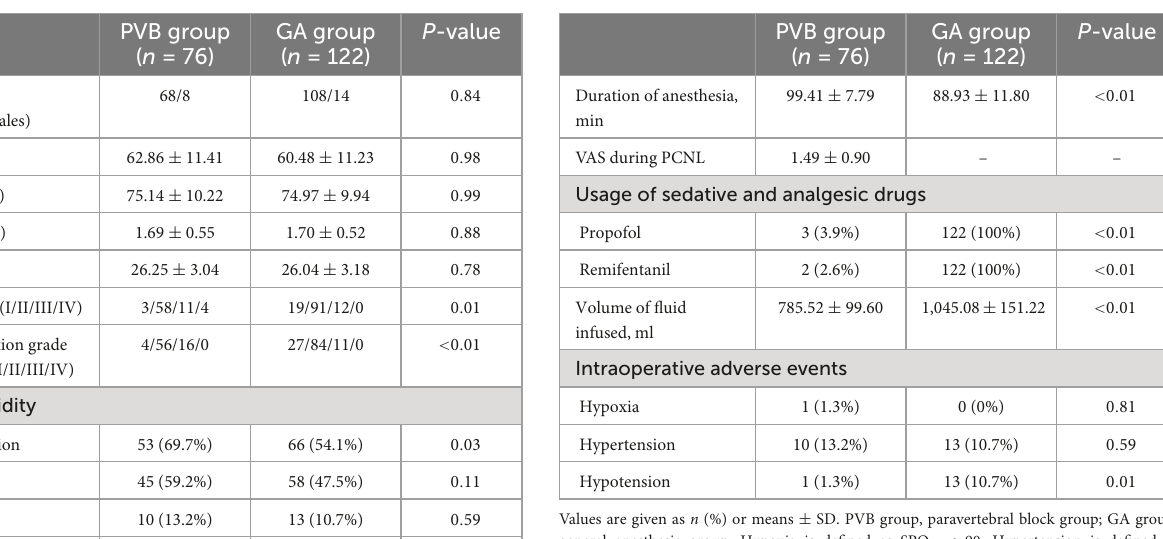
TABLE 1 Characteristics of included patients.